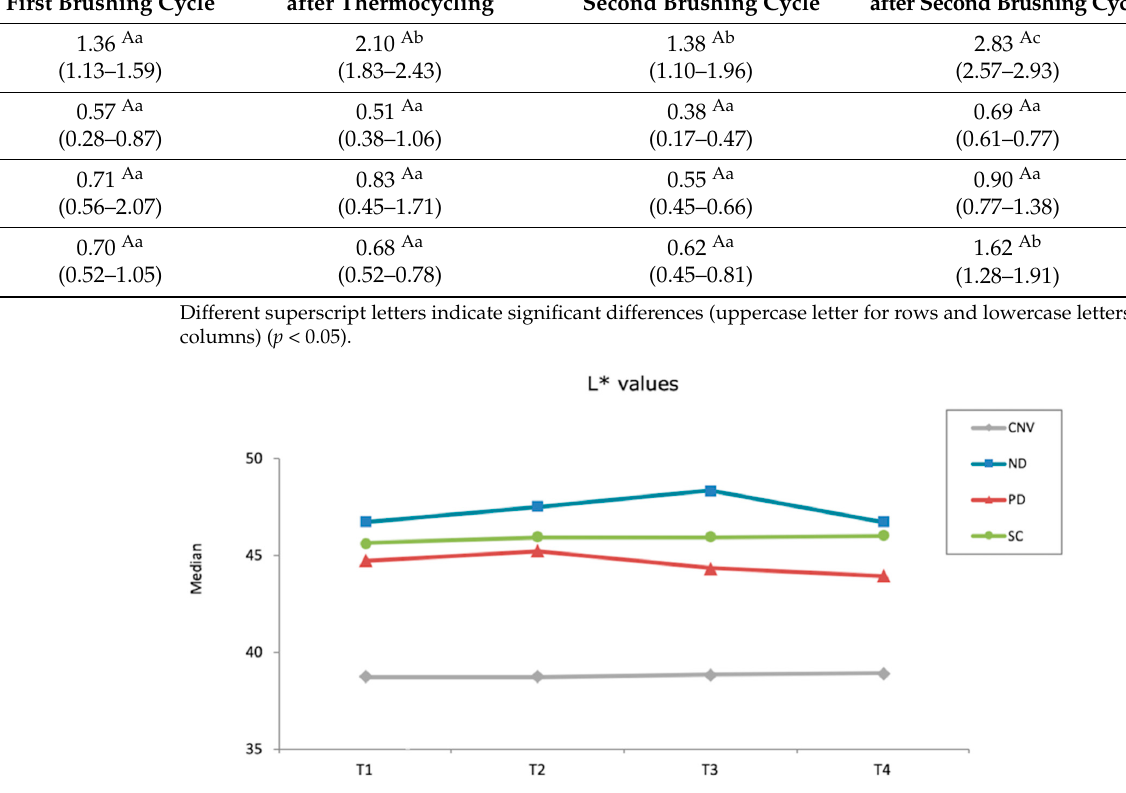
Figure 1. L* values of each material after each procedure (T1: After polish; T2: After first brushing